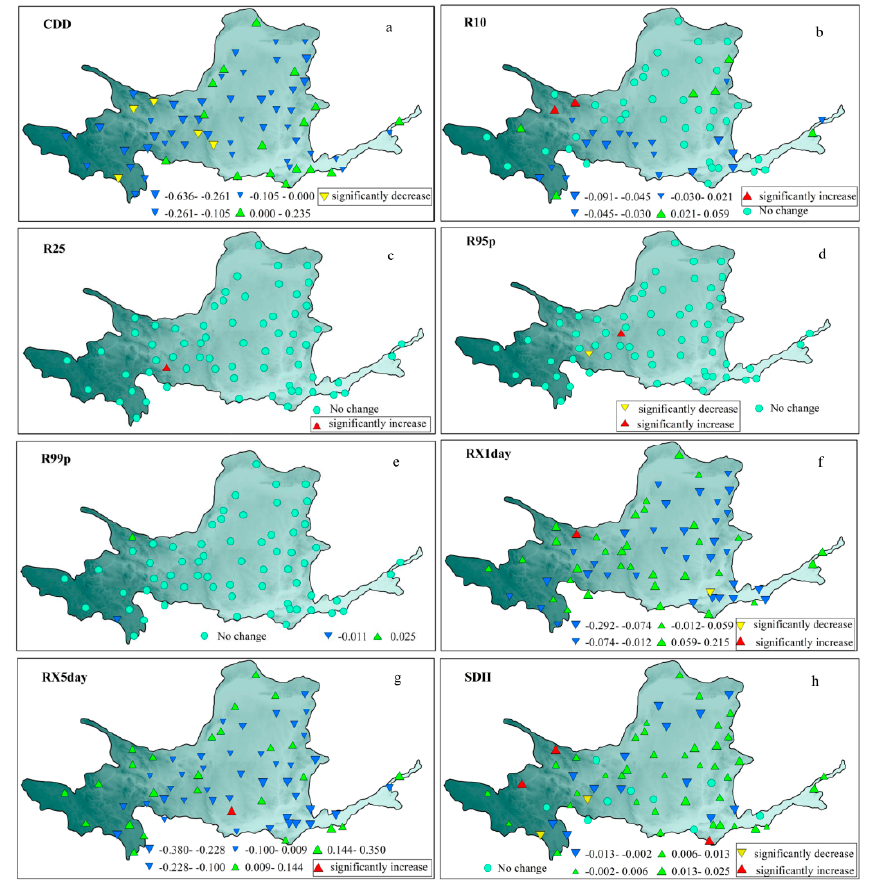
Figure 2. Interannual variation of precipitation extreme indices in the Yellow River basin (YRB) during 1960–2017. Table 2. Percentage of stations with positive (significant at the 0.01 level), negative (significant at the 0.01 level), and stationary trends for the trend test in annual extreme precipitation indices during 1960–2017.